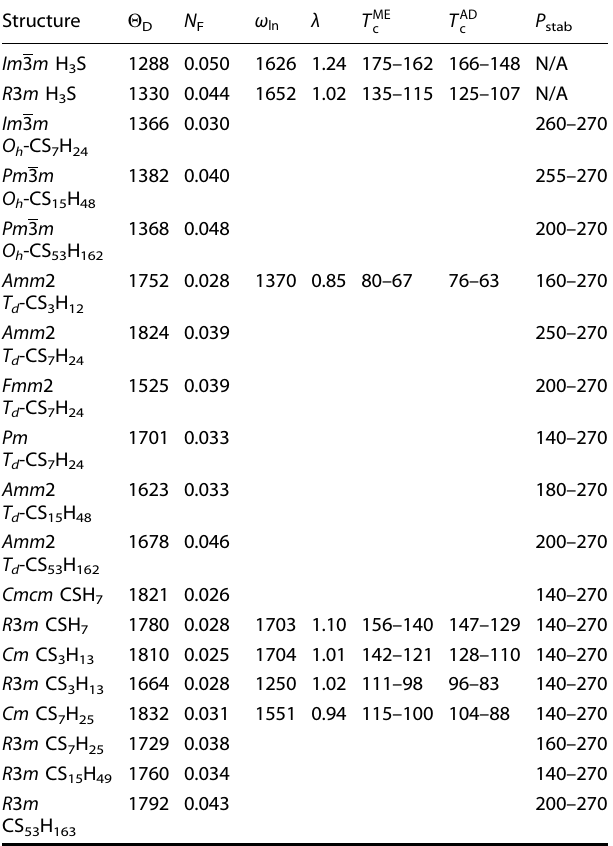
Table 1. Electronic, vibrational, and superconducting properties of dynamically stable phases at 270